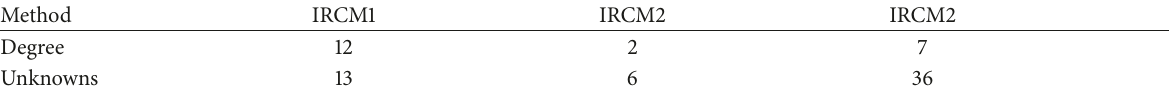
Table 2: Number of coefficients to compute for IRCM1-IRCM2 and PC at the considered degrees.